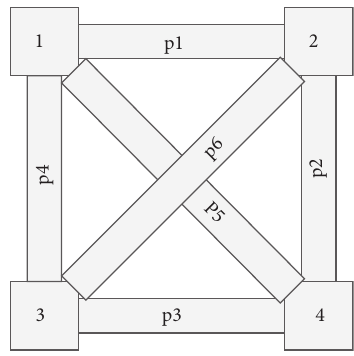
Figure 3: Location of classrooms and paths. Table 5: Capacity of each classroom.